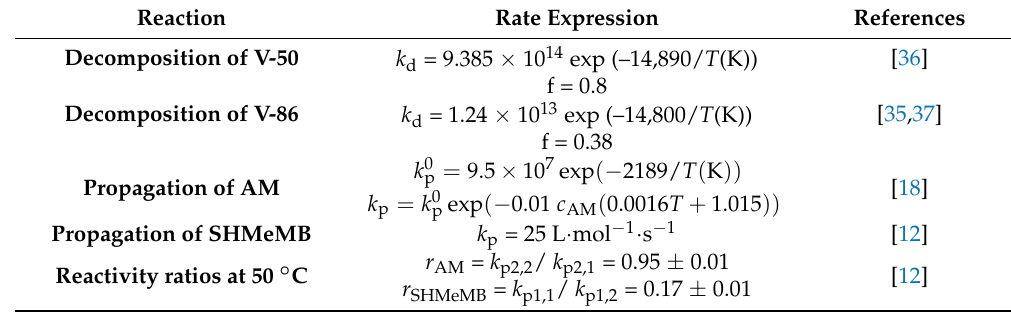
Table 2. Rate expressions for known kinetic coefficients used in model of SHMeMB:AM copolymerization.